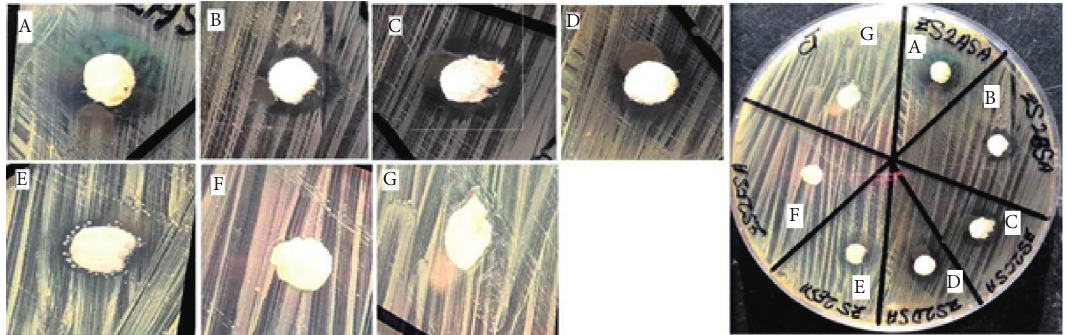
Figure 15: Antibacterial activity of ZnO/Ag nanocomposite against S . aureus . The paper disks were impregnated with the following suspension of copper oxide nanoparticles: A � 5mg/ml, B � 2 mg/ml, C � 1 mg/ml, D � 0.5 mg/ml. E � 0.25mg/ml, F � 0.1mg/ml, and G � 0mg/ml.